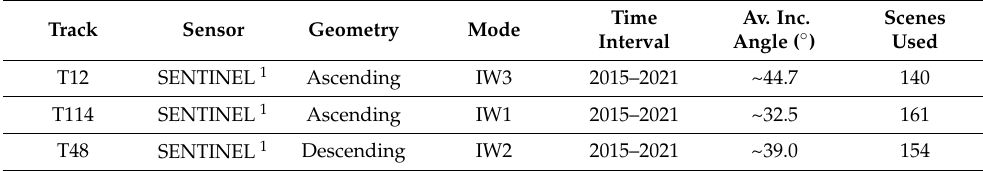
Table 1. Data coverage from each track used in this study. Track Sensor Geometry Mode